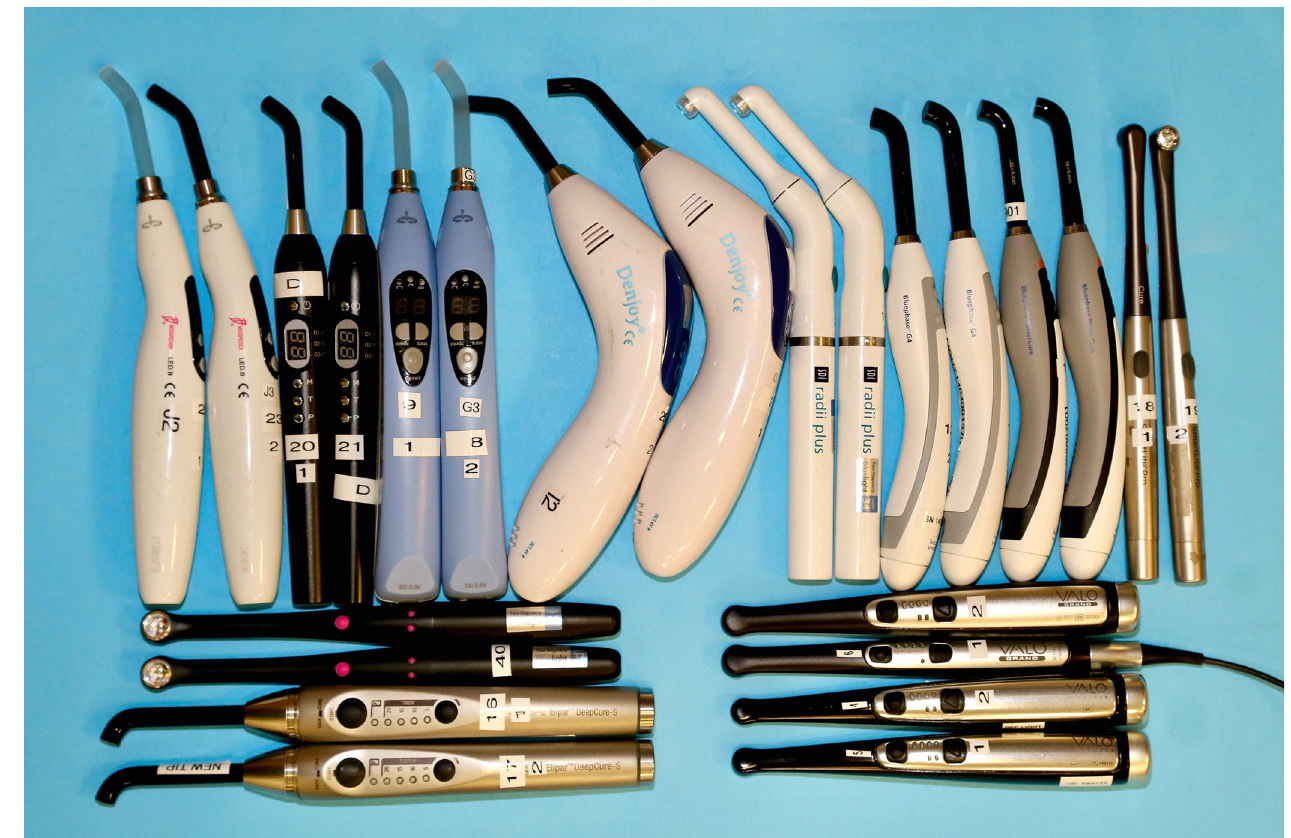
Fig 1. Units #1 and #2 of each brand of light-curing unit used in the